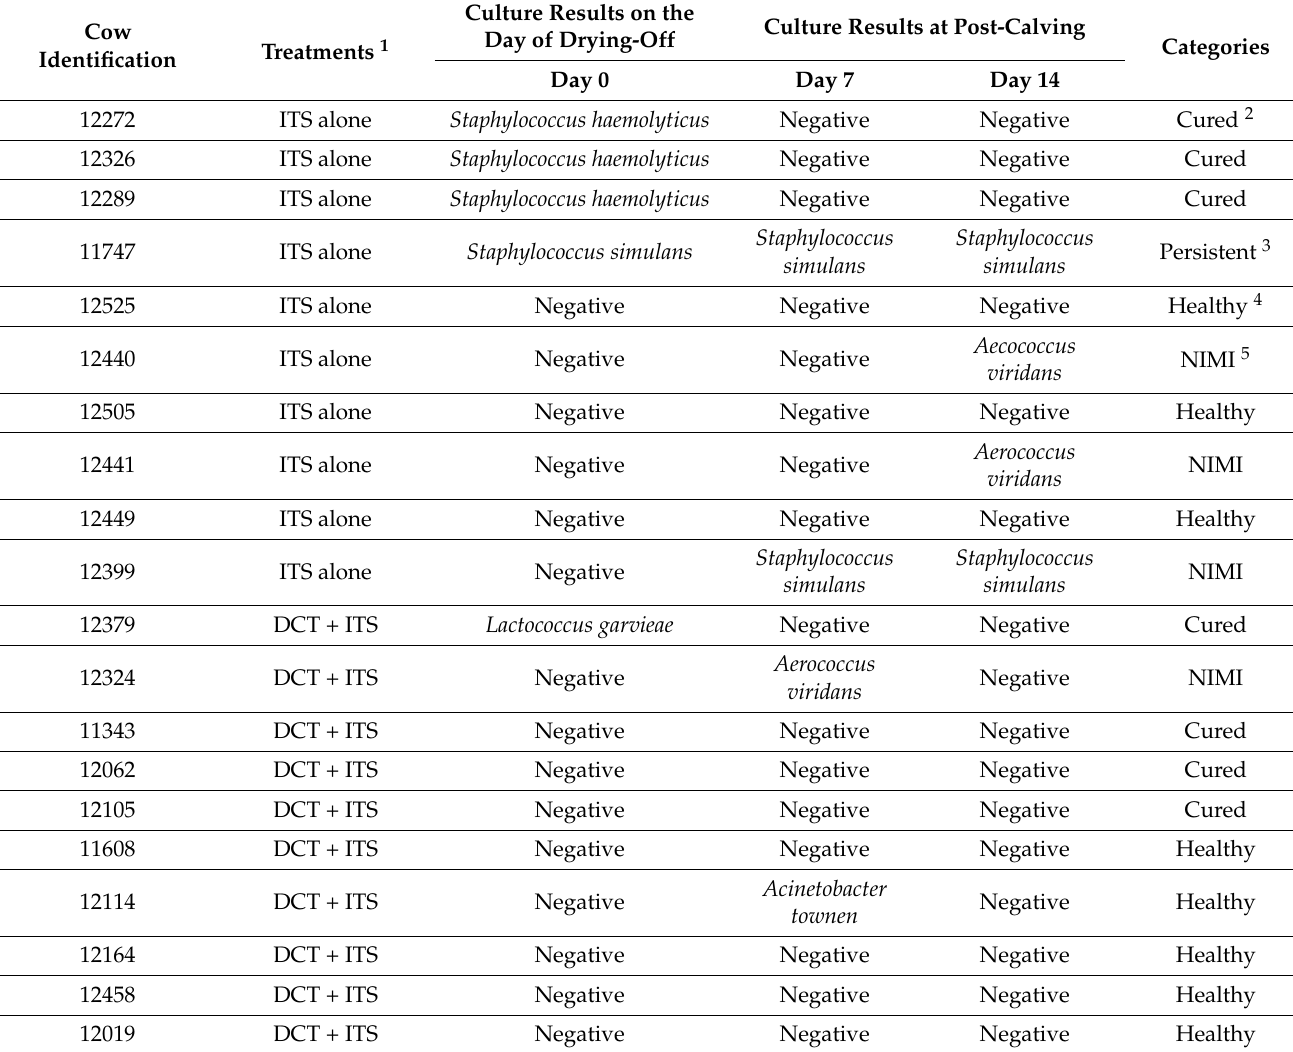
Table 1. Culture results (day 0: the drying-off day, and on days 7 and 14 post-calving), on-farm established groups for the adoption of drying-off protocols, and category